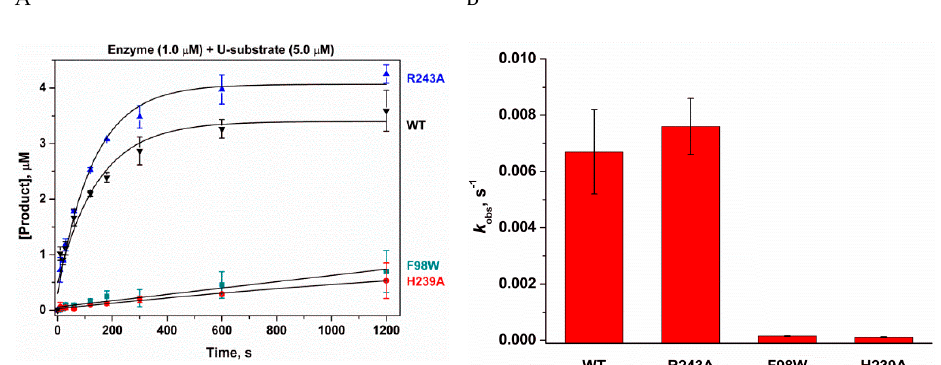
Figure 6. Accumulation of the reaction product ( A ) and relative activity ( B ) of WT hSMUG1 and mutants F98W, H239A, and R243A during the interaction with the model DNA duplex containing a U / G pair as determined by PAGE. [Enzyme] = 1.0 × 10 − 6 M, [Substrate] = 5.0 × 10 − 6 M.